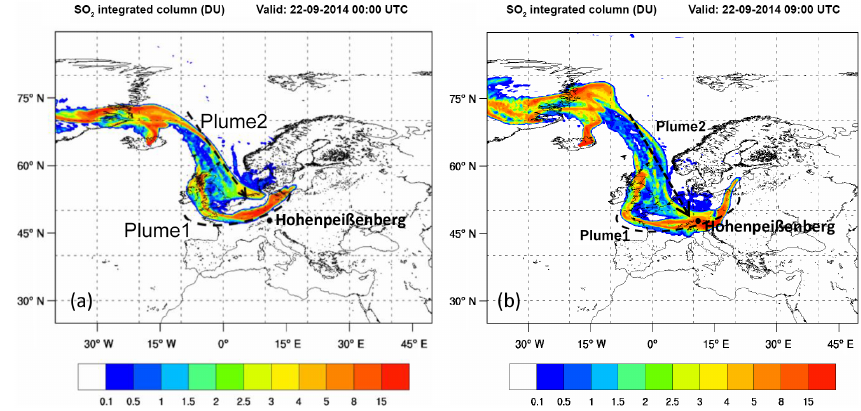
Figure 2. Integrated column of SO 2 (DU) from Bárðarbunga emissions as simulated with FLEXPART-WRF model, (a) 22 September 2014 00:00UTC; (b) 22 September 09:00UTC. Dashed lines indicate the orientation of the two distinct plumes overlapping over central Europe.